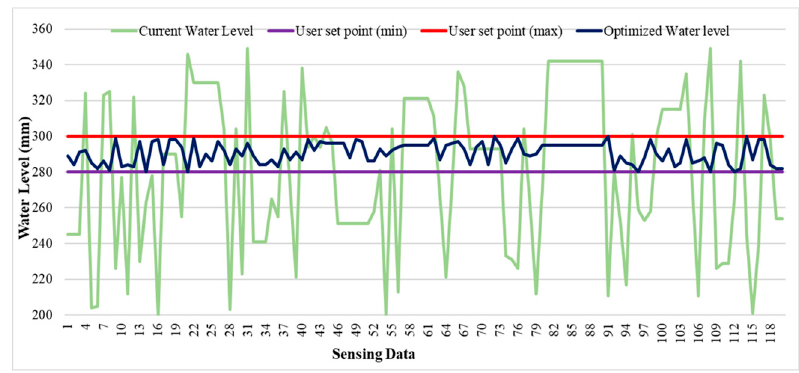
Figure 12. Optimization scheme results for the water level.